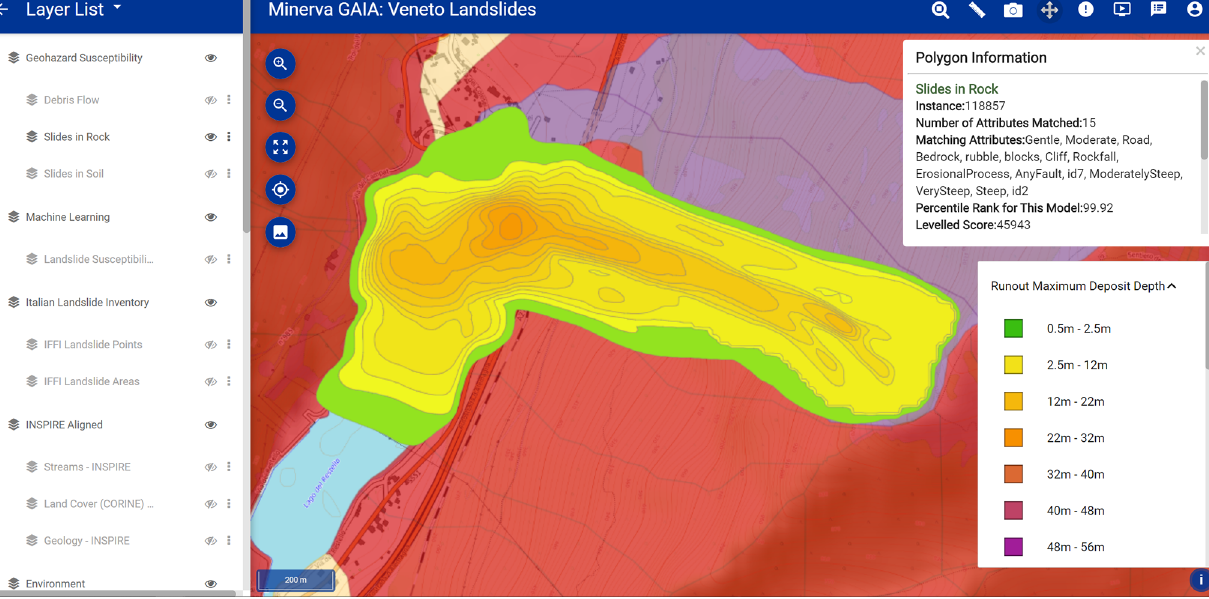
Figure 7. Screen capture of the web map showing layer list, information pop-up window, map legend, and landslide run-out. Base map credit: © OpenTopoMap